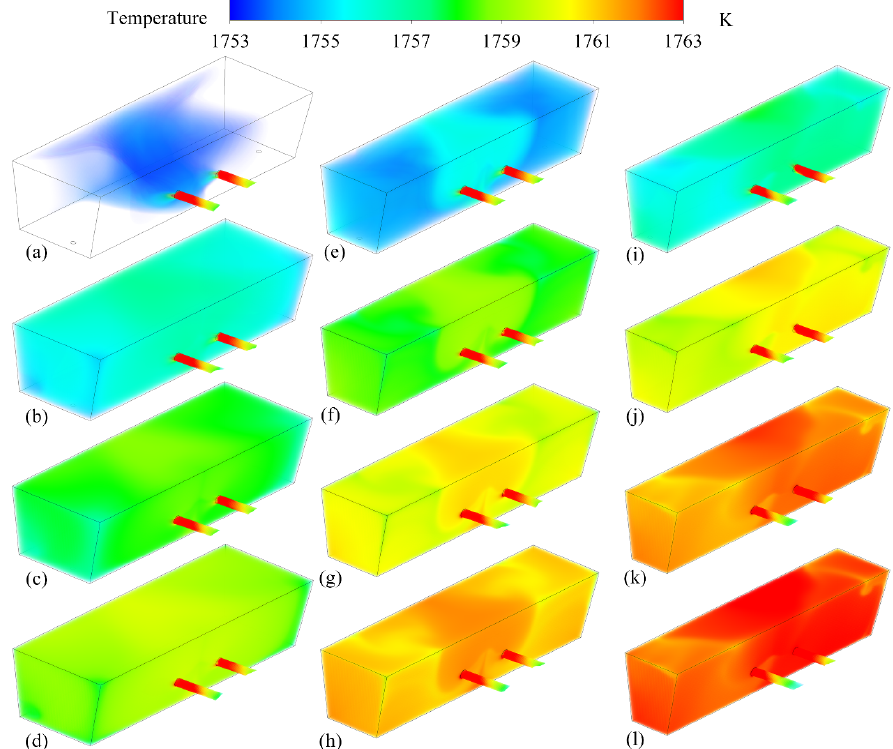
Figure 10. Variation of bulk temperature in distributing chambers. ( a – d ) are temperature distribution of molten steel in distributing chamber of tundish A at 600, 1200, 1800, and 2400 s in sequence; ( e – h ) and ( i – l ) are temperature distributions of the molten steel in distributing chambers of the tundishes B and C at corresponding moment, respectively.